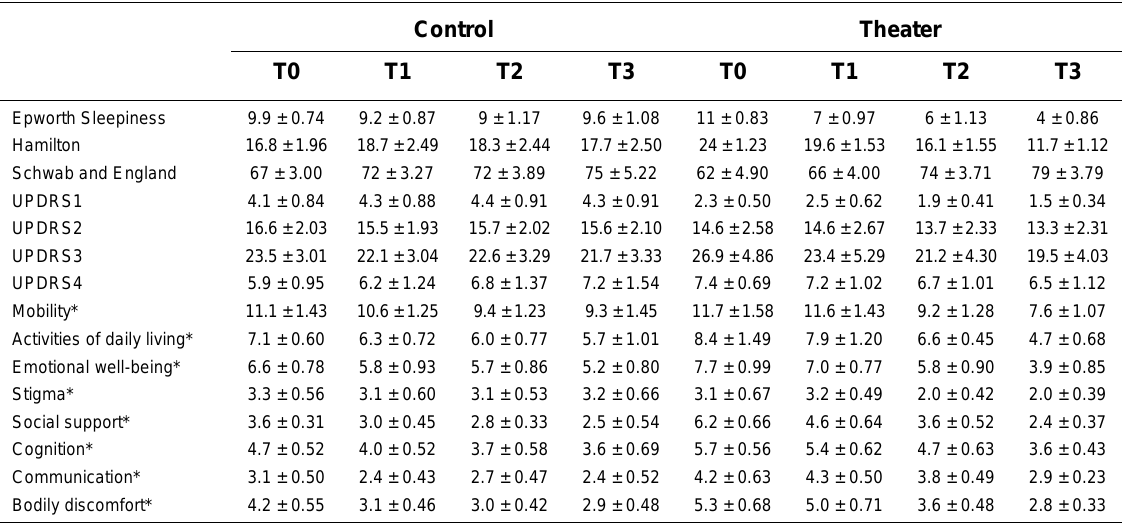
Mean Scores and Standard Error Mean Obtained by the Two Groups of PD Patients (Control Group and Theater Group) in the Five Clinical Scales (and Subscales) at the Four Time Points Control Theater